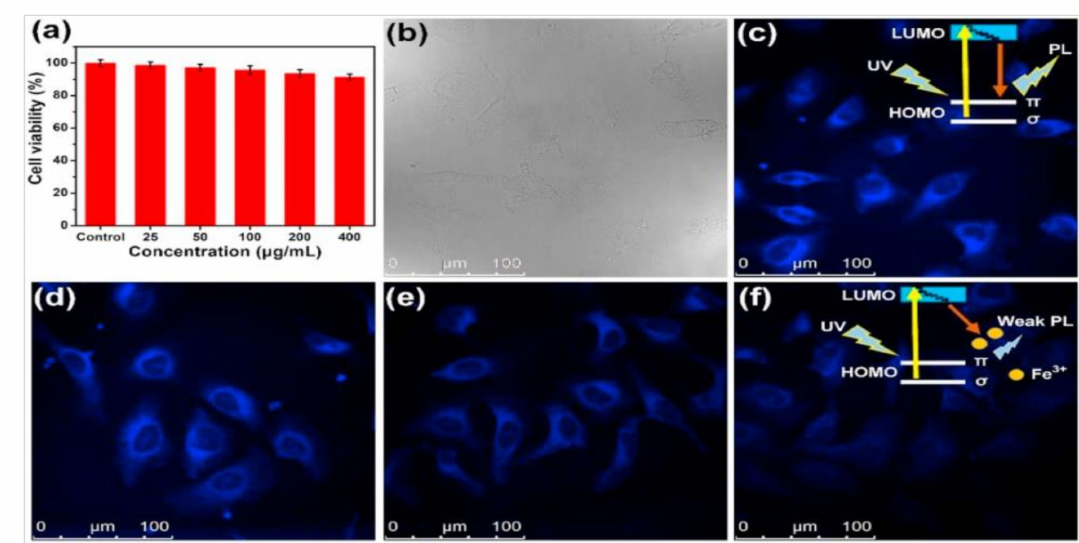
Figure 12. ( a ) Cell viability of HeLa cells after incubated with di ff erent concentrations of N / S-doped C-dots obtained from cellulose-based biowaste for 24 h; ( b – f ) fluorescence images of HeLa cells incubated with N / S-doped C-dots (40 µ g / mL) under di ff erent conditions (( c ): N / S-CDs only, ( d – f ): mixture of N / S-CDs and Fe 3 + with concentrations of 10, 20 and 40 µ M, respectively)